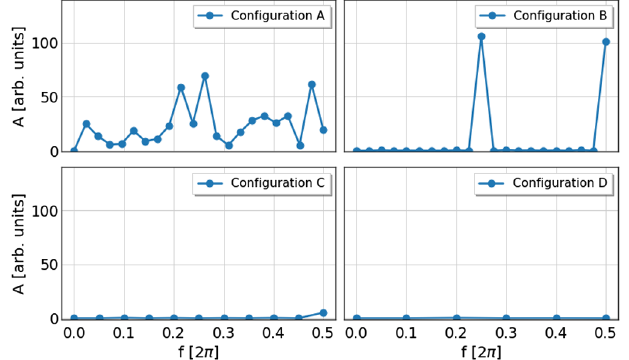
FIG. 10. Fourier spectra of the horizontal beta functions signifying the periodicities of the optics for each BPM configu- ration. The name of each configuration is shown in the legend.